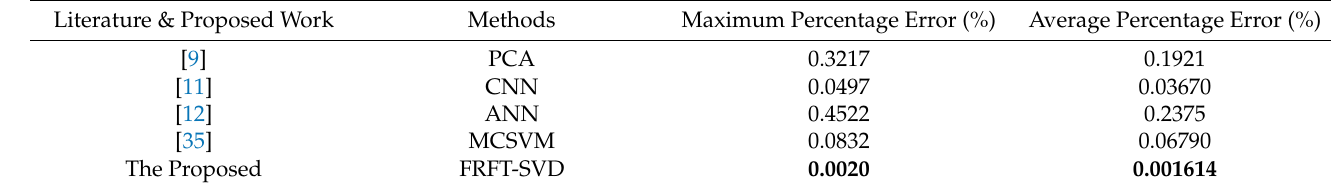
Table 15. Validation of the proposed algorithm compared to literature work in